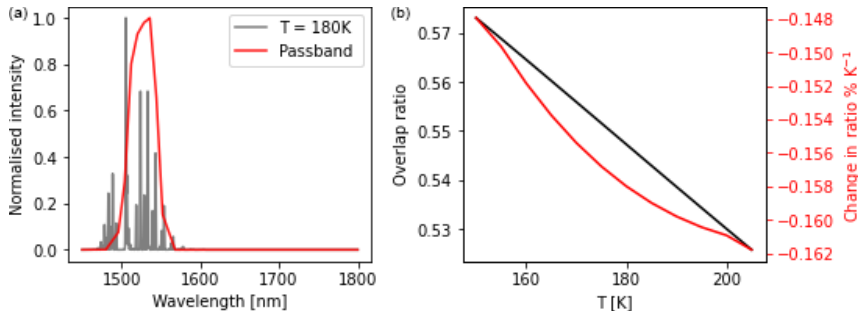
Figure 1. (a) The HITRAN-modelled OH (3-1) spectrum at a temperature of 180 K (grey) and the IRI optical passband (red). (b) The overlap ratio (black) of the OH (3-1) emission band (spectral interval of 1.45–1.8µm) as a function of temperature and its relative change (red).